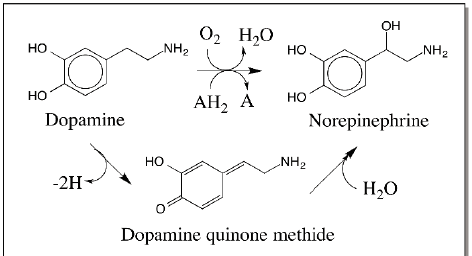
Figure 7. Mechanism of dopamine hydroxylation reaction. Initially, oxidation of dopamine to a